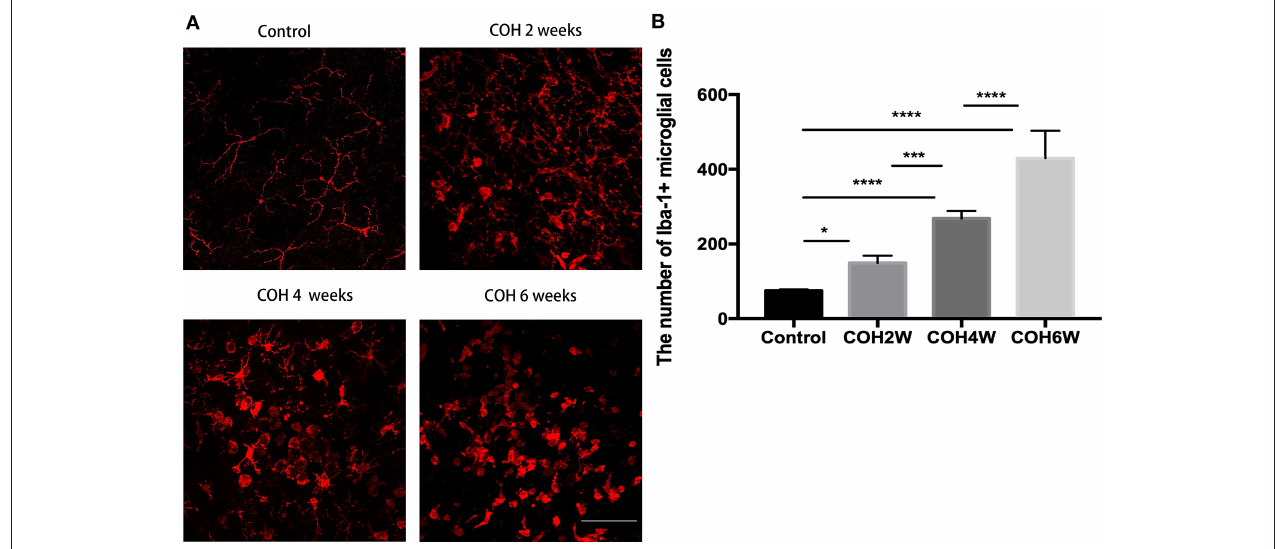
FIGURE 5 | Activation of microglial cells induced by COH. (A) Immunofluorescence staining of Iba-1 proteins in retinal whole mounts. In the group of COH, microglial cell showed amoeba morphological change (magnification × 200, scale bar = 50 µ m). (B) The number of Iba-1 + microglial cells in COH mice. The number and activation of microglial cell increased with the prolonged duration of COH. Data were analyzed using one-way ANOVA followed by Tukey’s post hoc test (* p < 0.05, *** p < 0.001, and **** p < 0.0001). N = 16 mice (control group: 4 mice; hydrogel injection group: 12 mice). Bars represent mean ± SD.